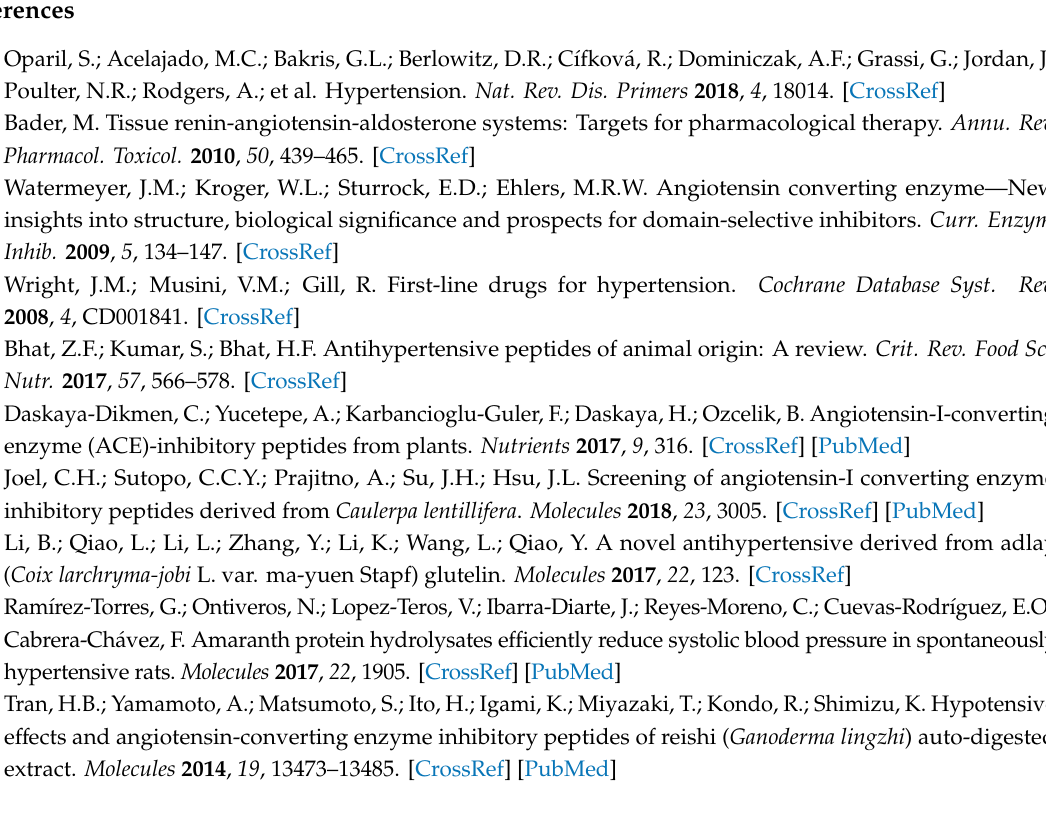
Figure S1: E ff ects of CSBp5 on diastolic blood